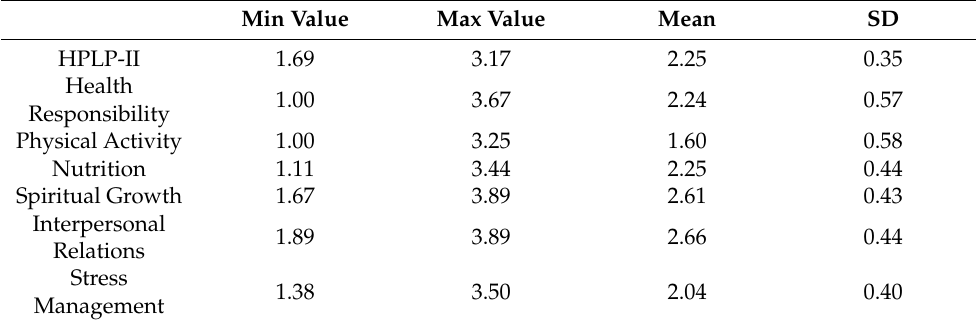
Table 2. Descriptive statistics of Health-Promoting Lifestyle Profile II (HPLP-II)